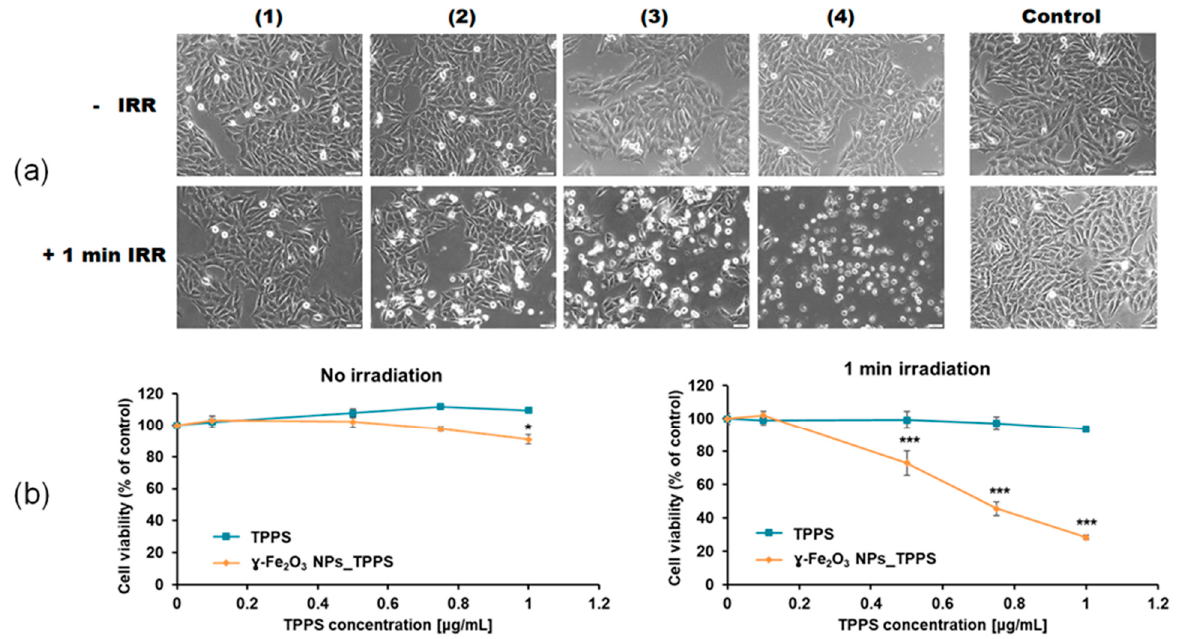
Figure 12. The effect of no irradiation vs. irradiation ( λ ~ 405 nm, 1 mW/cm 2 , 1 min) conditions on morphology and viability of treated Mel-Juso cells. ( a ) Bright-field images of Mel-Juso cells after 24 h exposure to different concentration of γ -Fe 2 O 3 NPs_TPPS complex: (1) 0.5 µ g/mL NPs and 0.1 µ g/mL TPPS; (2) 2.75 µ g/mL NPs and 0.5 µ g/mL TPPS; (3) 4.16 µ g/mL NPs and 0.75 µ g/mL TPPS; (4) 5.5 µ g/mL NPs and 1 µ g/mL TPPS and subjected or not to led irradiation. Magnification 10X. Scale bar is 50 µ m. ( b ) Cell viability of Mel-Juso cells after 24 h incubation with TPPS and γ -Fe 2 O 3 NPs_TPPS complex at different concentrations. Data ( n = 3) were expressed as percentages related to control ± standard deviation (SD). The results were considered statistically significant when * p < 0.05; *** p < 0.001 (sample vs. control).